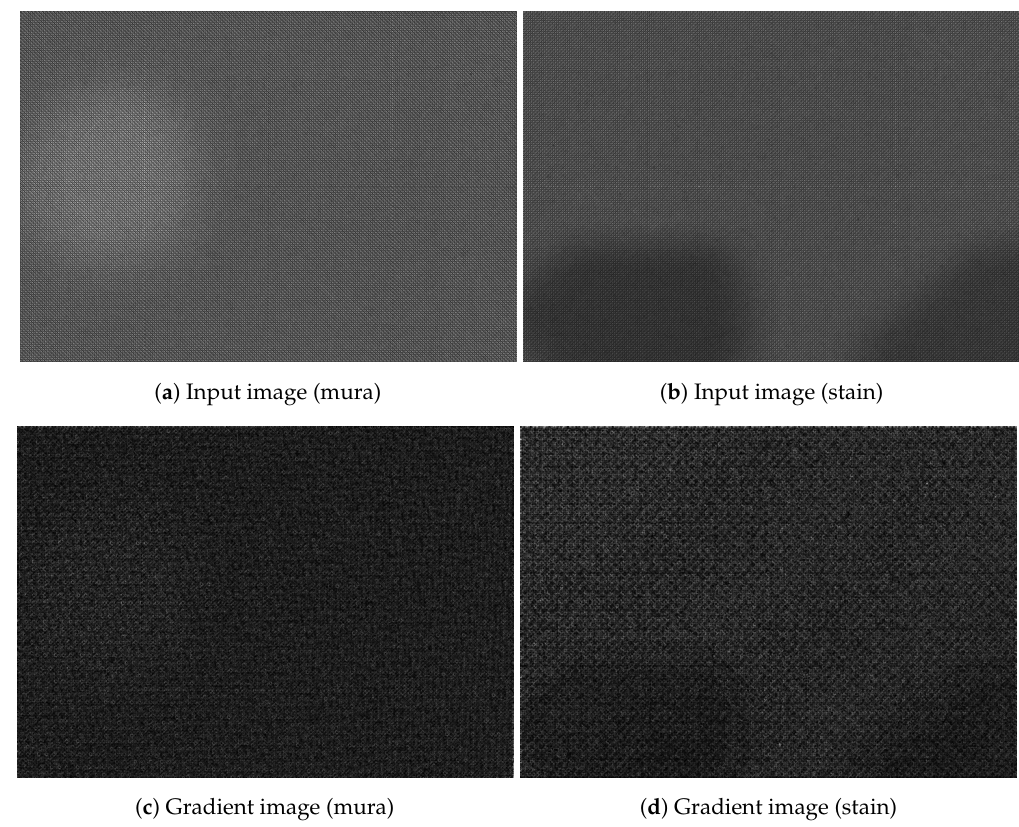
Figure 11. Examples of result of gradient and binary